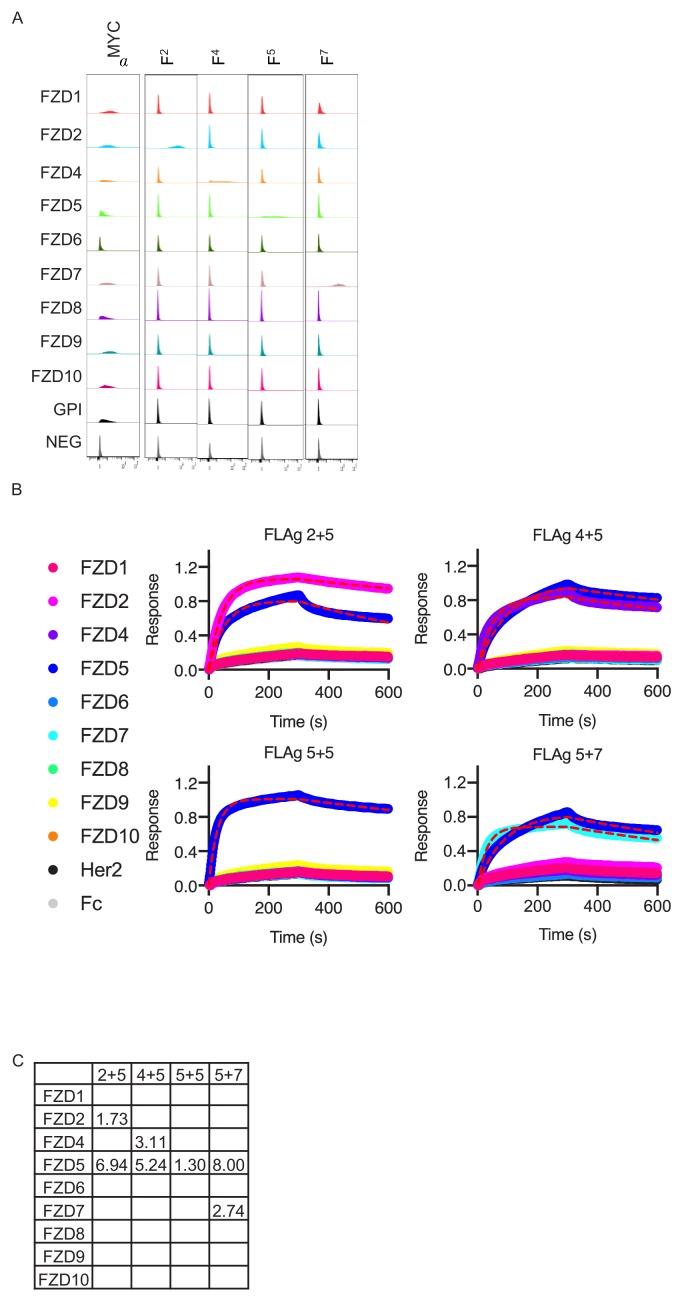
Selectivity of Fabs for FZD CRD expressed on cells.(A) Flow cytometry specificity analysis of selective FZD Fabs (Steinhart et al., 2017). The specificity of each Fab was determined by measuring binding to a panel of recombinant CHO lines displaying each FZD ECD at the cell surface using a GPI anchor (Myc-FZD ECD-GPI). Cells were stained with 10 nM of each Fab and binding evaluated using flow cytometry. (B) Raw chromatograms of FLAg specificity by BLI. (C) Table of extrapolated KD (nM) from locally fit kinetics of each FLAg to human FZD ECDs using a 1:1 Langmuir model.